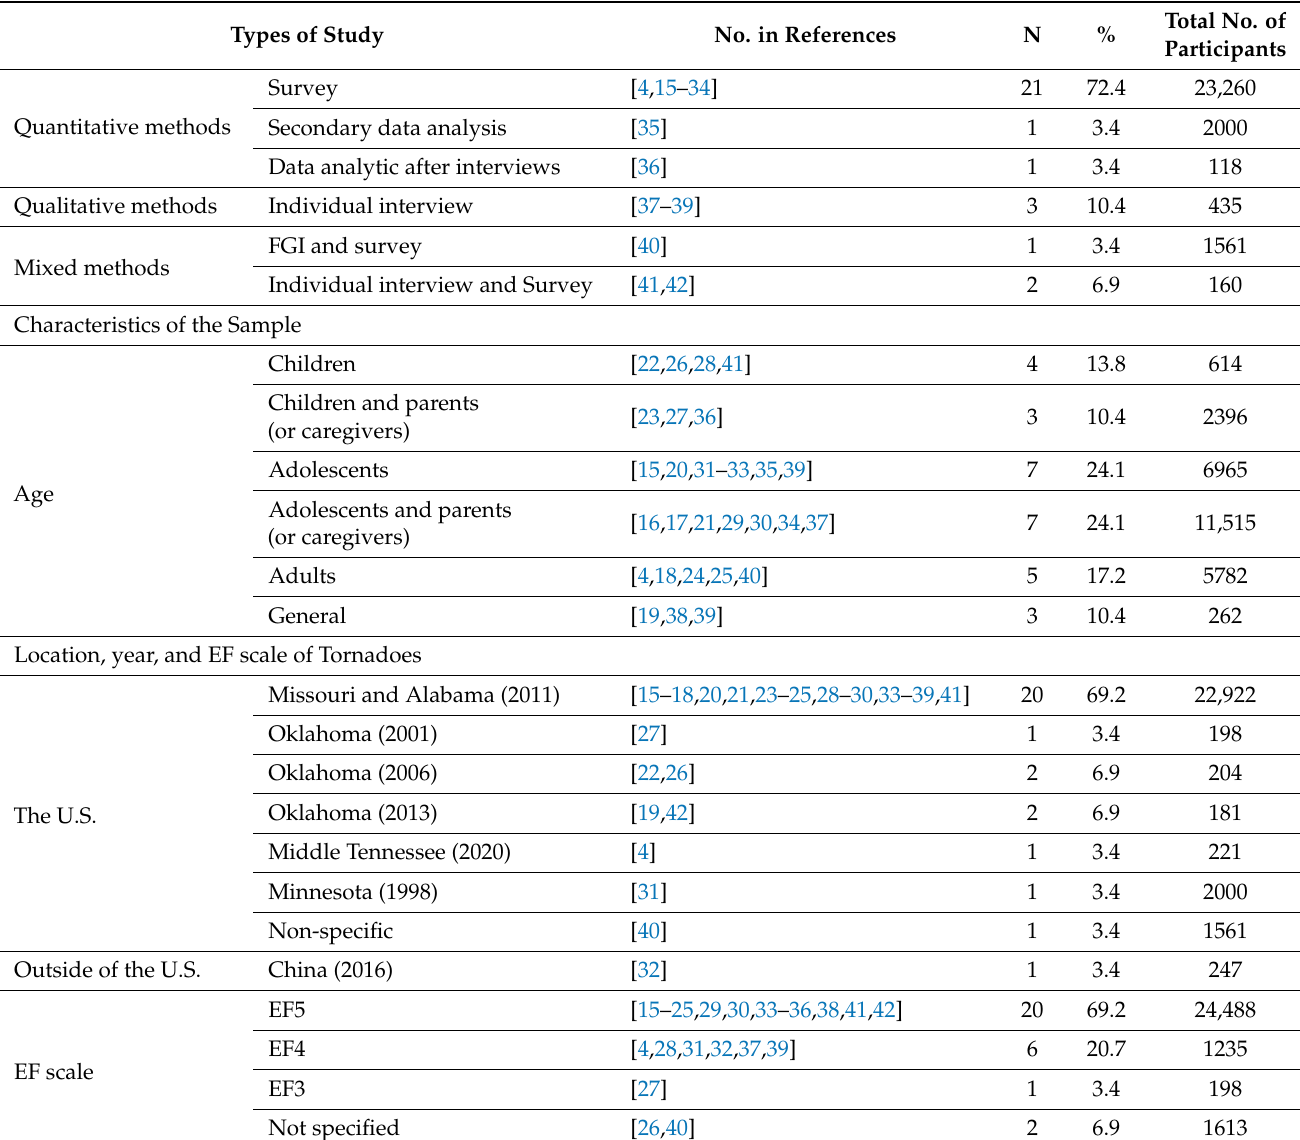
Table 1. Summary of the characteristics of included